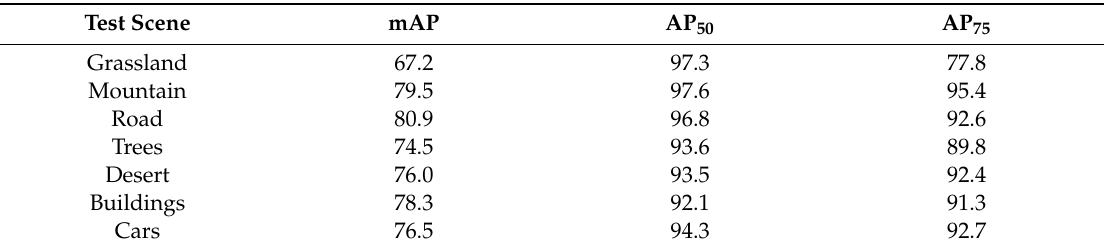
Table 7. Recognition results of the deep convolutional neural network (DCNN)-based method on di ff erent test